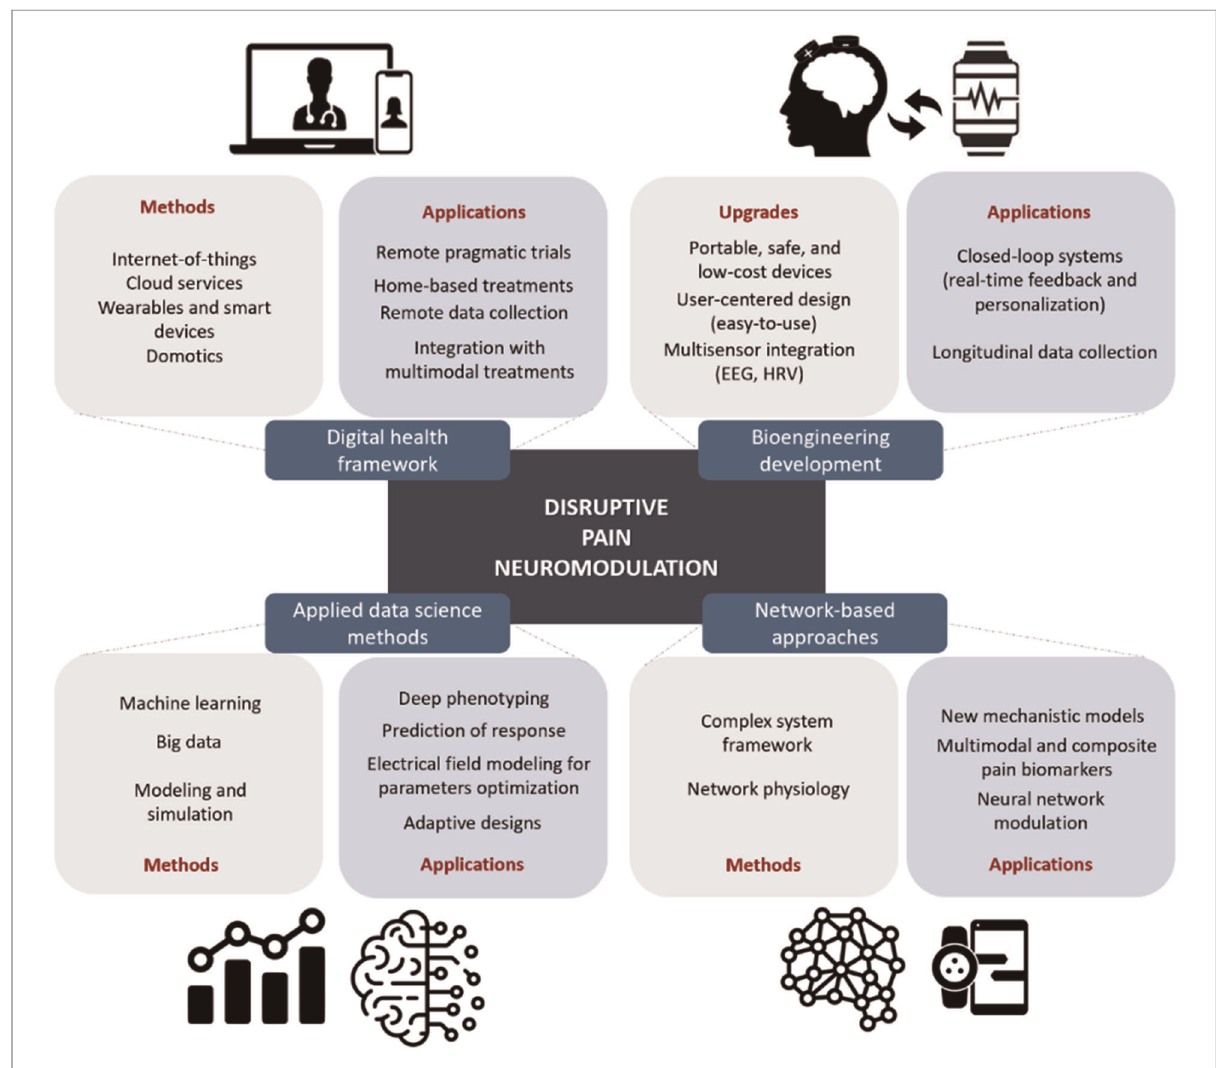
FIGURE 1 Development areas for disruptive pain neuromodulation